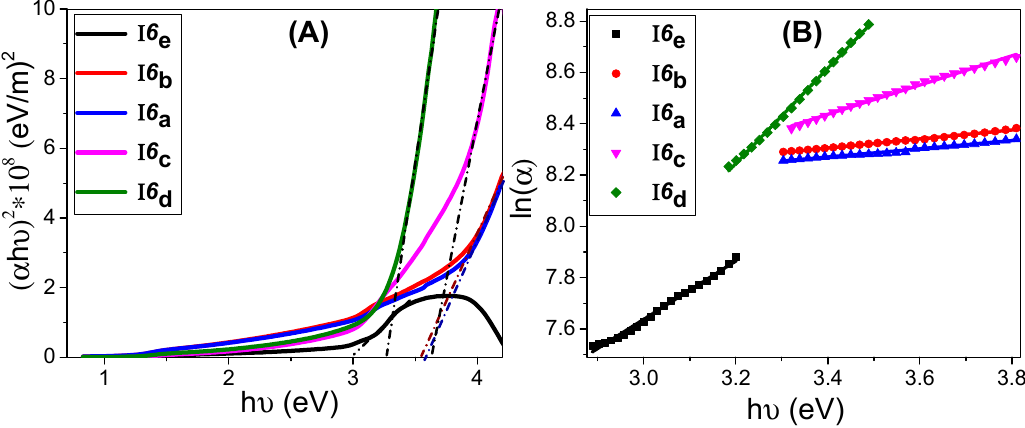
Figure 11. Calculation of ( A ) energy gap and ( B ) Urbach energy for the present series ( I6 a–e ) at 115 °C. Table 2. Values of the energy gap (E g ) and Urbach energy (E U ) for analogs series I6 a–e .